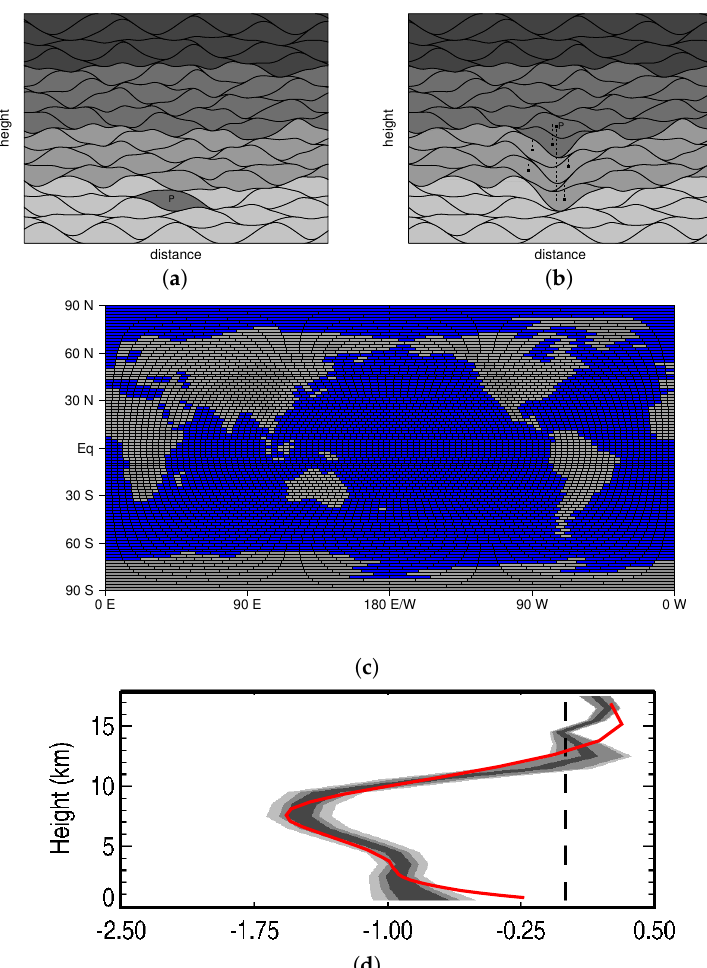
Figure 1. The Lagrangian atmospheric model. ( a , b ) conforming parcel concept and convective parameterization (from [12]). Local heating causes parcel P to become warmer than its neighbors (darker shades denote higher potential temperatures), and the convective parameterization raises P to its level of neutral buoyancy. Dashed lines trace paths of parcel centers with significant vertical displacements. ( c ) the new spherical land and ocean geometry. ( d ) net radiative heating (K/day) over the West Pacific Warm Pool for the radiation scheme (red) compared with observationally based estimates from